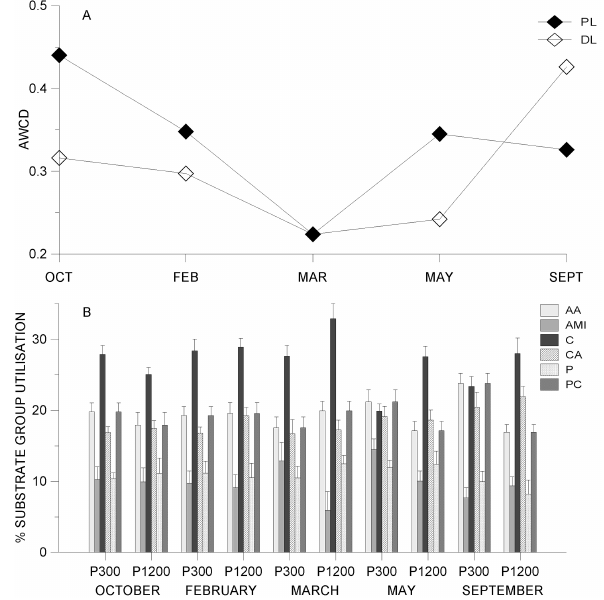
Figure 9. Changes of MC (mean AWCD) in the productive and deeper layers (A) ; percentage utilization of substrate groups (AA – P1200 and P300 (B) during the cruises (3 October 2011, 18